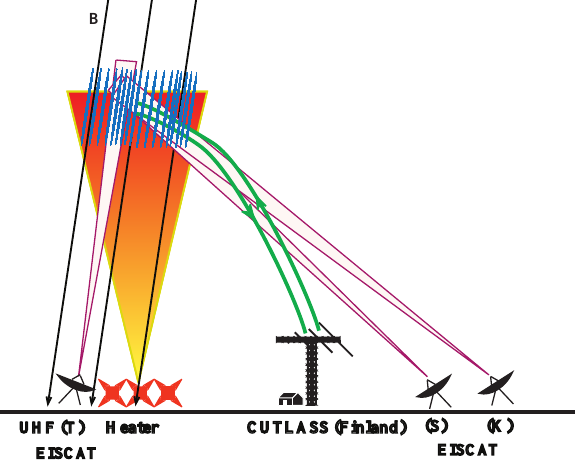
Fig 1. Fig. 1. A schematic of the artificial backscatter experiment, SP-UK- OUCH. The Tromsø heater continuously heats the F -region iono- sphere, creating artificial ionospheric irregularities. Both the CUT- LASS HF coherent backscatter radars, operating in a high temporal and spatial resolution mode, detect these irregularities. Measure- ments are also available from the EISCAT UHF incoherent scatter